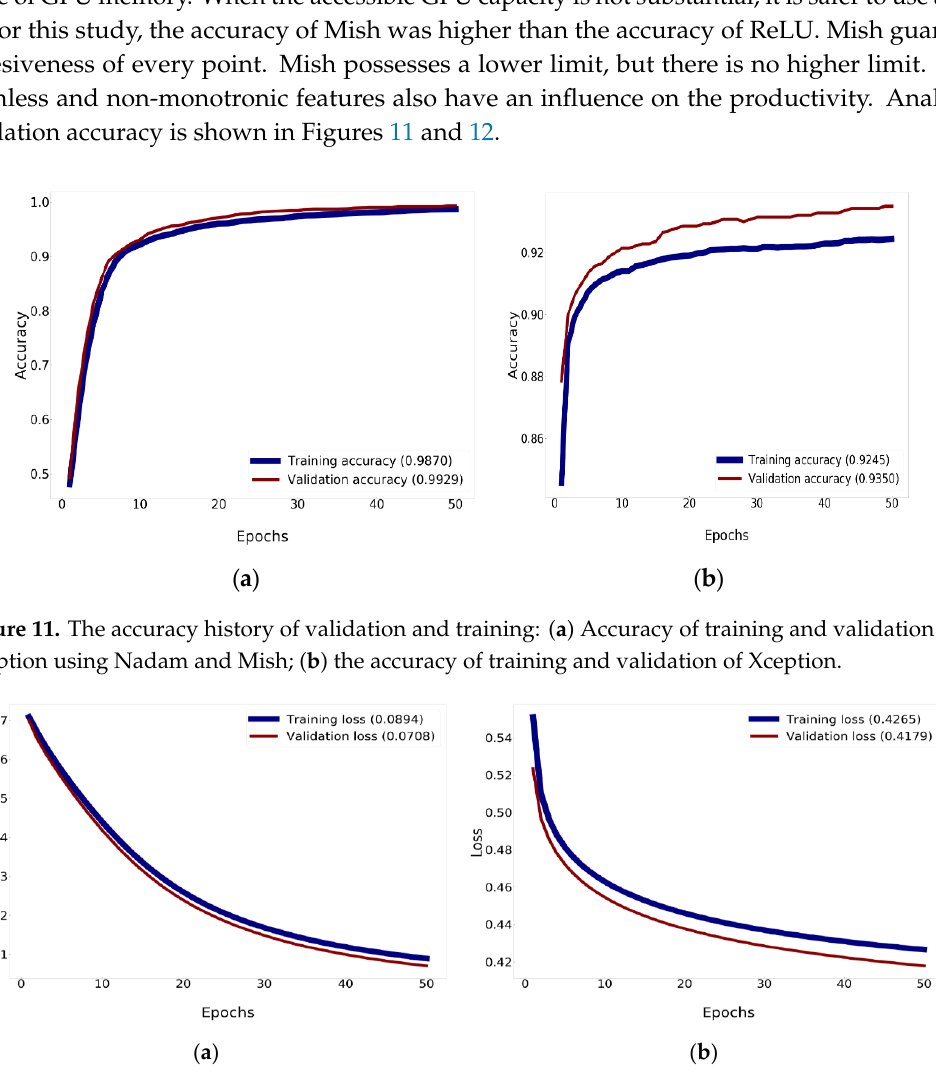
Figure 12. The loss history of validation and training: ( a ) The loss of training and validation of Xception using Nadam and Mish; ( b ) the loss of training and validation of Xception.